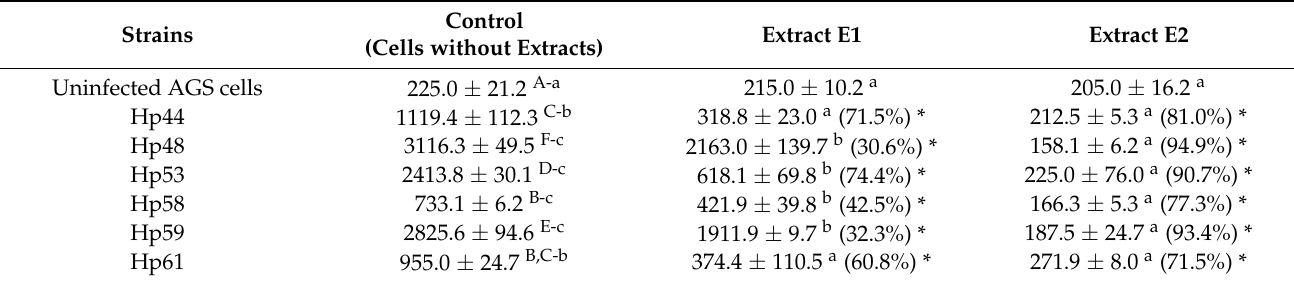
Table 2. Effect of olive-leaf extracts (E1 and E2) on IL-8 production in AGS cells infected by H. pylori strains. Values of IL-8 production are expressed as pg/mL (mean ± standard deviation) ( n = 3). Strains